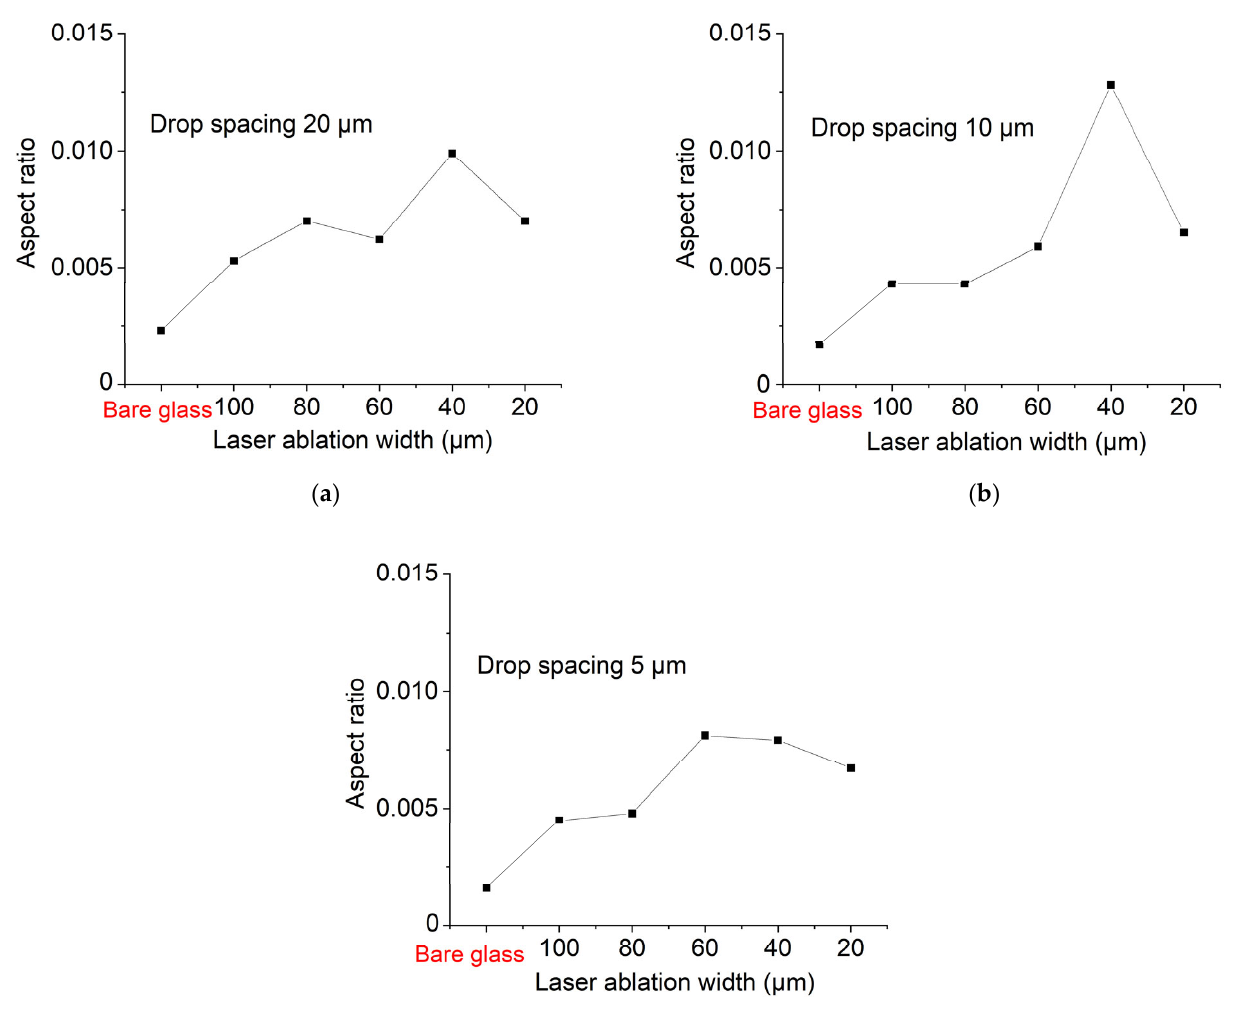
Figure 9. Variation in cross-sectional aspect ratio of printed lines as a function of laser ablation width for inkjet drop spacings of ( a ) 20 µm, ( b ) 10 µm, and ( c ) 5 µm.